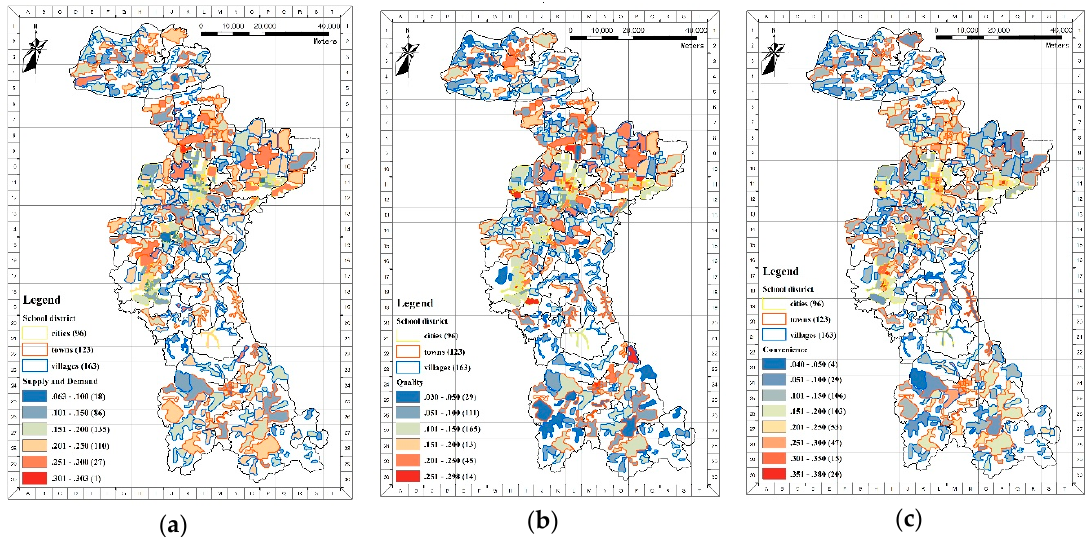
Figure 3. The distribution of three categories scores including ( a ) supply and demand scores; ( b ) quality scores; ( c ) convenience scores in Zibo City.